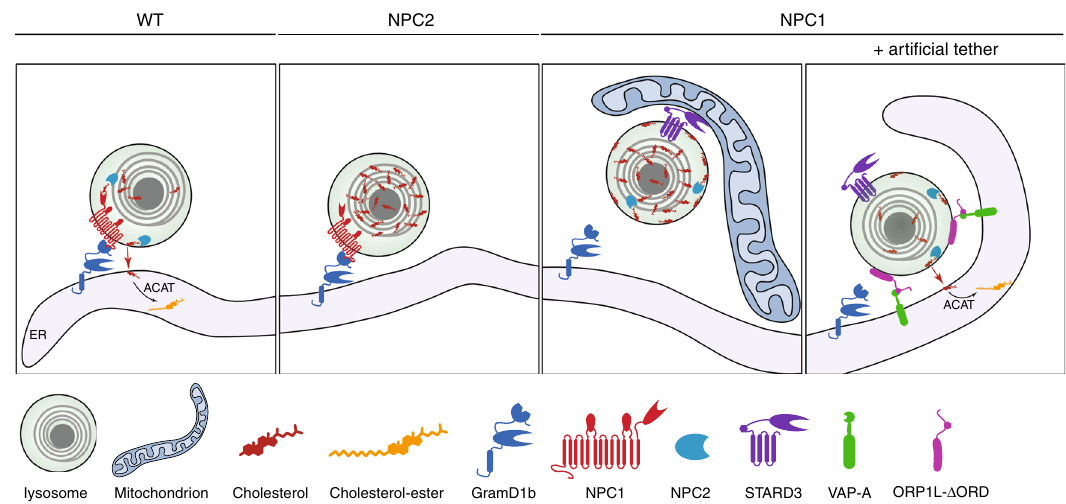
Fig. 7 Reciprocal relationship between lysosomal cholesterol and NPC1-regulated MCS. A schematic representation of cholesterol transport at NPC1- regulated lysosomal MCSs. In the presence of cholesterol in the endocytic pathway, lysosomal NPC1 interacts with Gramd1b on the ER to tether MCSs that mediate the transport of cholesterol from the endosome to the ER for esteri fi cation by ACAT. In the absence of functional NPC2, luminal cholesterol fails to be delivered to the limiting membrane for egress at NPC1-Gramd1b tethered MCS and therefore accumulates in the lysosome. In the absence of functional NPC1, NPC1-tethered lysosome-ER contact sites are lost and cholesterol accumulates in the lysosome. Under these conditions STARD3 mediates extended lysosome contact sites with mitochondria. However, when the lysosome is arti fi cially tethered to the ER by expression of an ORP1L mutant with its sterol- binding domain deleted (ORP1L- Δ ORD), cholesterol transport to the ER is